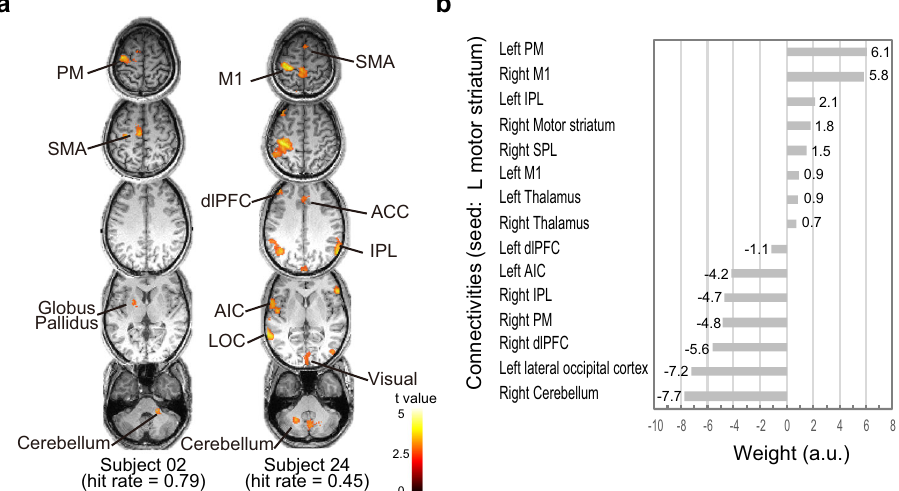
Fig. 5 Effective connectivity with dorsal striatum represents individual differences in BCI performance. a Effective connectivity analysis in two representative participants. Subject 02, who had good BCI performance (hit rate of 0.79), showed BgCN connectivity only, whereas subject 24, who had poor BCI performance (hit rate of 0.45), showed NfCN connectivity in addition to BgCN connectivity. b The LASSO regression revealed that good BCI performance correlated with BgCN connectivity, whereas it was negatively affected by connectivity with NfCN, including the lateral occipital cortex, anterior insula cortex (AIC), dorsolateral prefrontal cortex (dlPFC), and inferior parietal lobule (IPL). Weights of the left IPL, M1, dlPFC, right motor striatum, superior parietal lobule (SPL), and bilateral thalamus were less than 3.0, which represents a weak